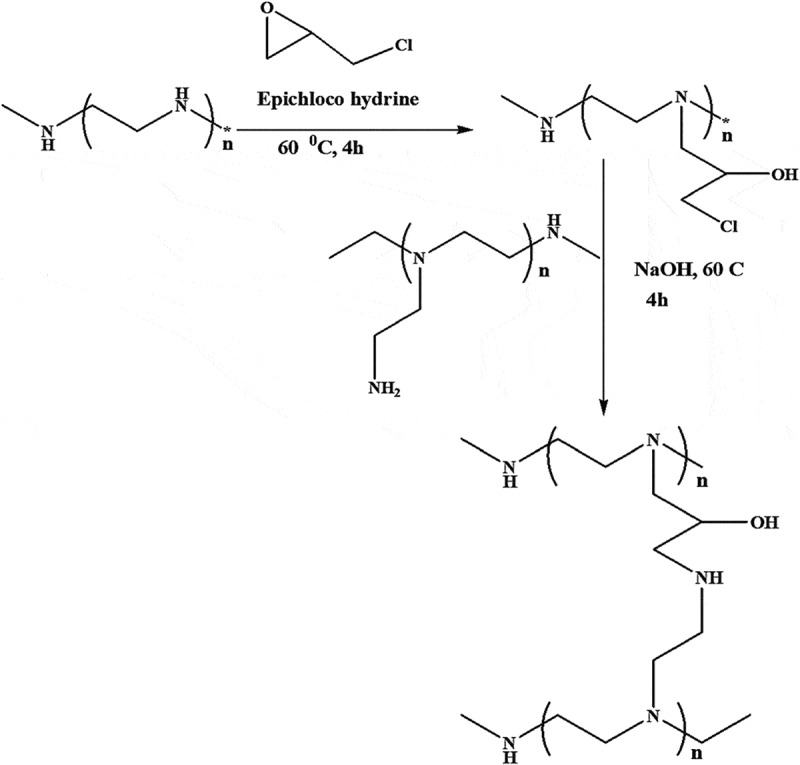
Schematic of BPEI copolymers preparation [20].